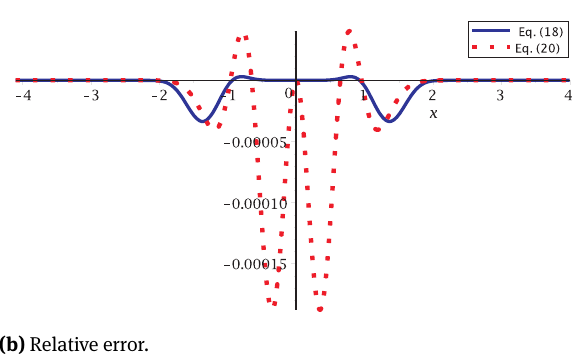
Figure 5: Gaussian distribution integral approximations and relative